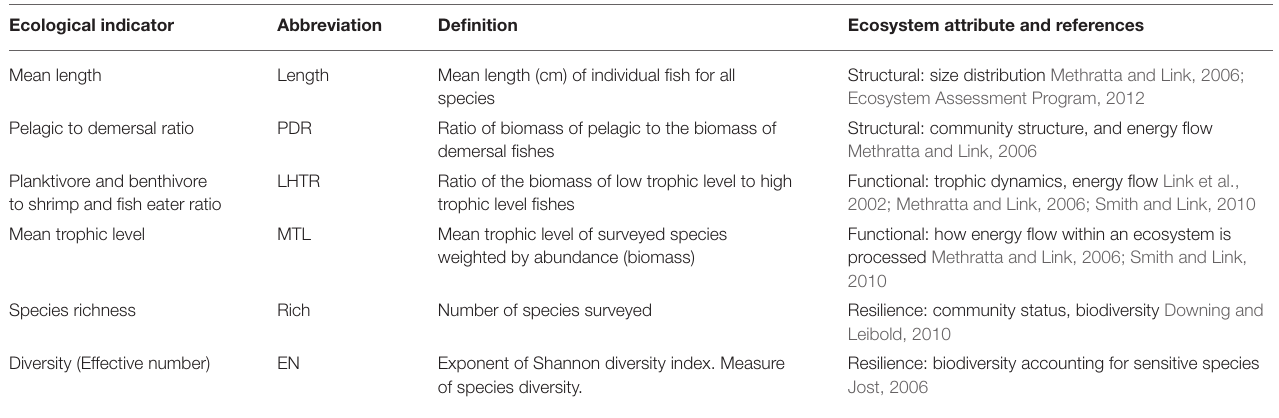
TABLE 1 | Ecological